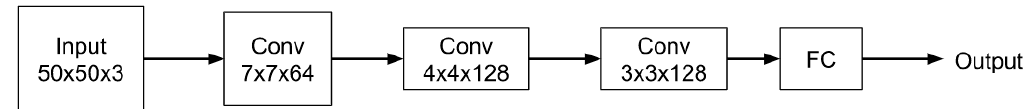
Figure 7. The proposed convolutional neural networks (CNN) algorithm.